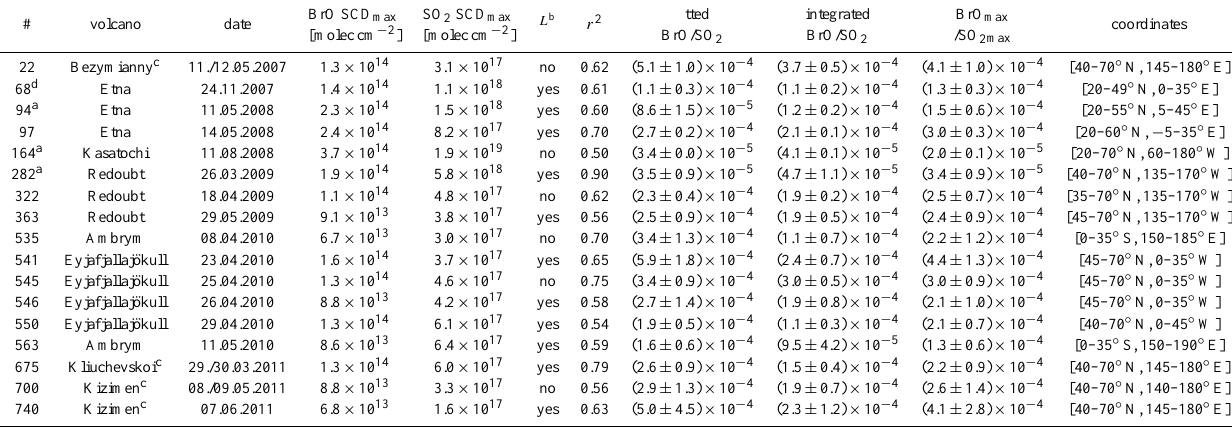
Table 4. Category I ( clear linear correlation ) BrO/SO 2 -analysis of all detected volcanic plumes of Category I. Columns contain: event number, volcano, measurement date, max. BrO SCD, max. SO 2 SCD, coincidence of max. SO 2 and BrO SCD, r 2 , BrO/SO 2 slope, ratio of integrated BrO and SO 2 molecules, ratio of max. SO 2 and BrO SCD and coordinates of regarded